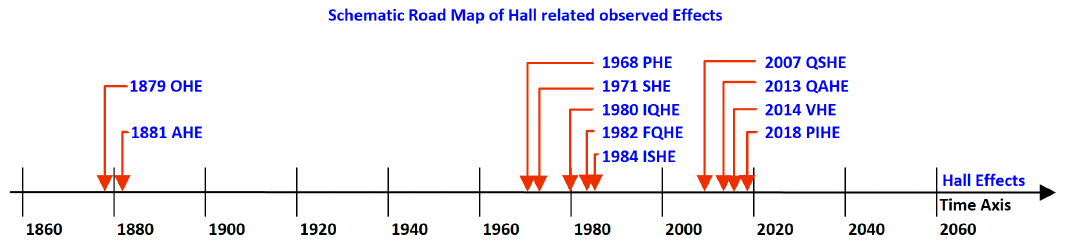
Figure 1. Schematic time line of the main Hall related observed Effects. OHE—Original Hall Effect;